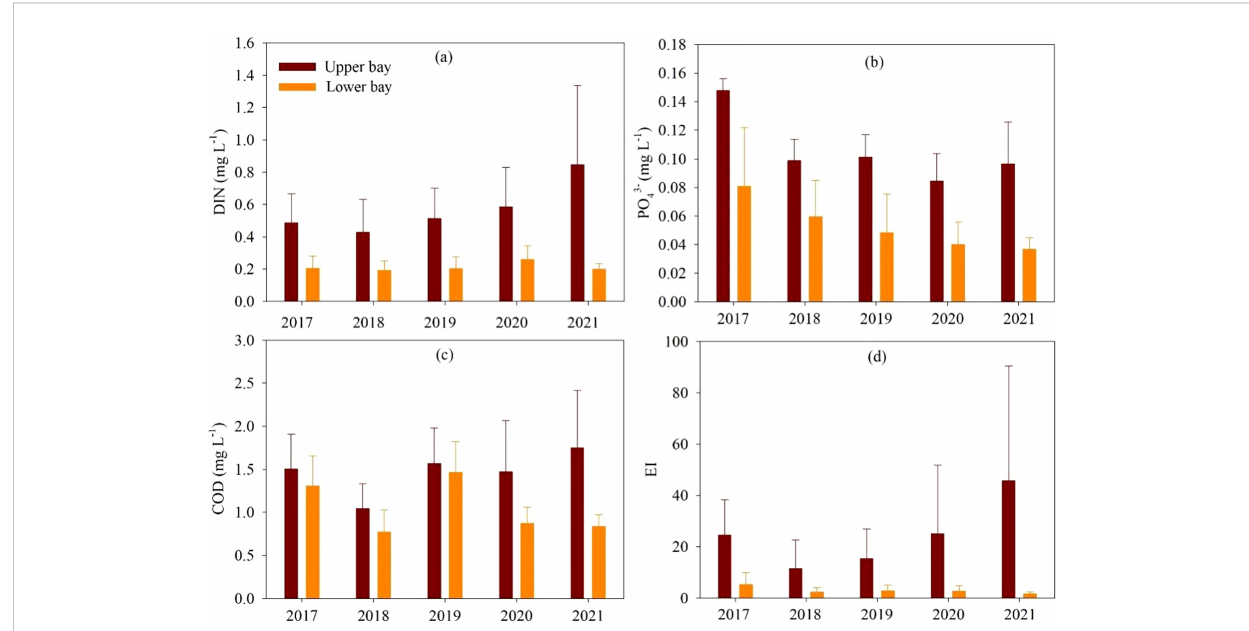
FIGURE 4 The distribution of nutrients, COD and EI in upper and mid bay from 2017 to